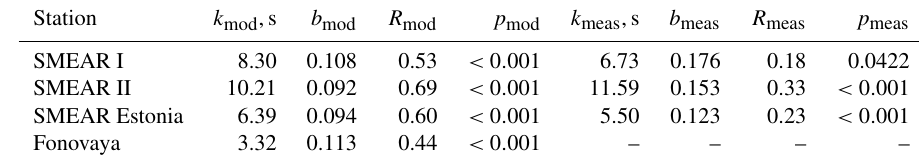
Table 3. Best fit parameters, correlation coefficients and p -values for radiation data ( R d /R g = k CS + b ).